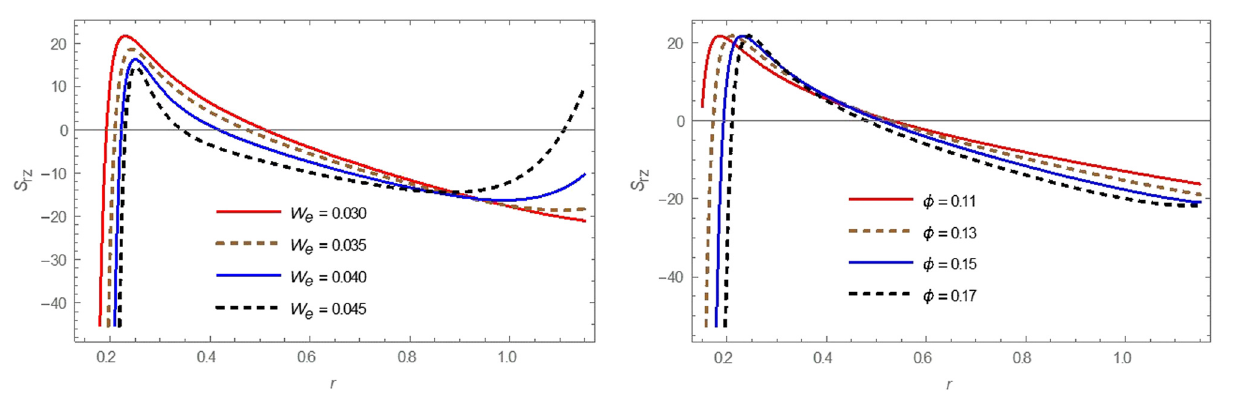
Figure 9: E ff ect of di ff erent values of ∅ on stress with W